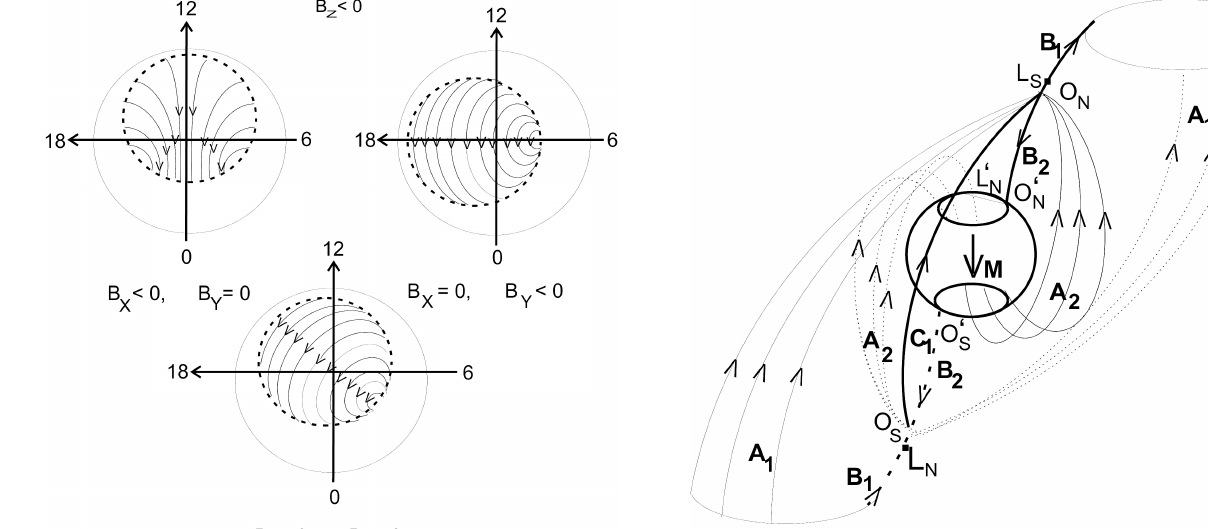
Fig. 3. Distribution of the electric equipotentials in the open field line region of the northern polar cap, in the spherical model, for southward IMF, B , dependent on b x and b y , ( b = k B , k =0.1).